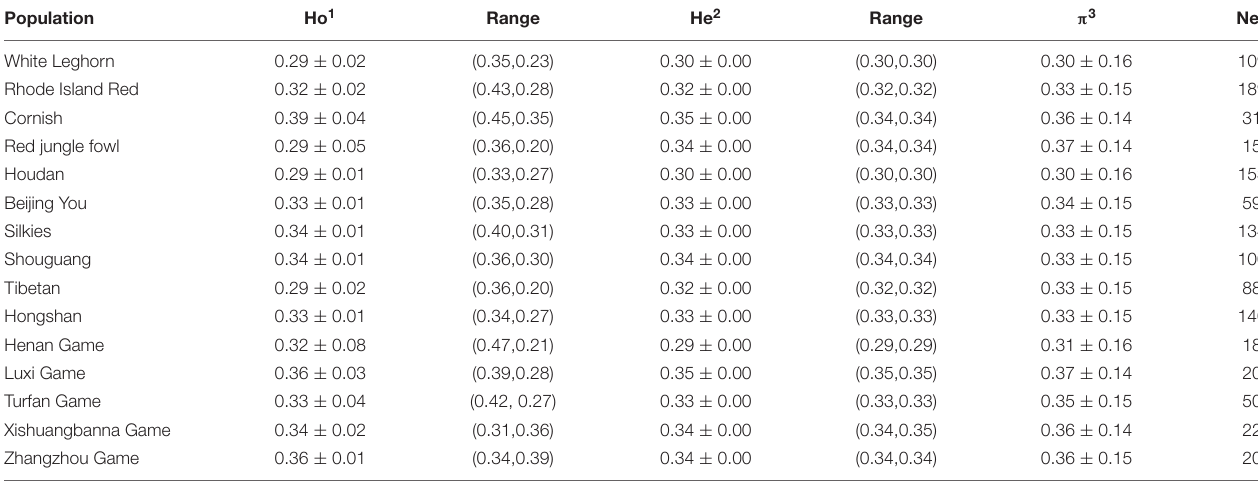
TABLE 2 | The genetic diversity estimates for different type breeds. Population